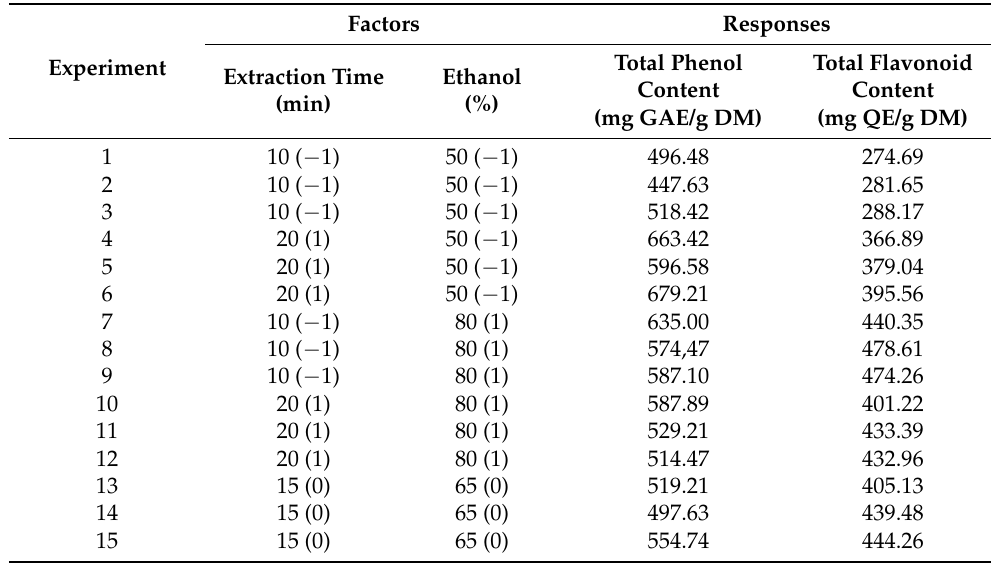
Table 1. Design and results for total phenol content and total flavonoid content of M. oleifera leaf extracts obtained by preliminary ultrasound-assisted extractions (UAE) experimental